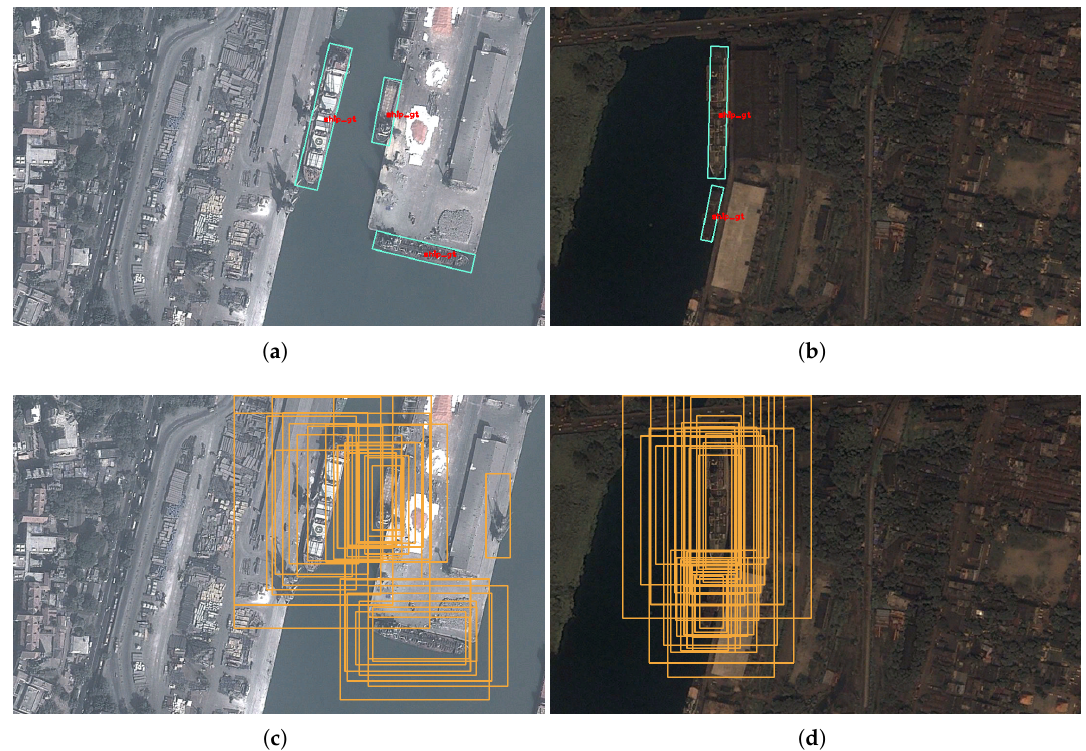
Figure 5. Ships region proposals of different scales. ( a , b ) the ground truth bounding boxes of ships; ( c , d ) the different scales region proposals of multiscale ships generated by region proposal network in our